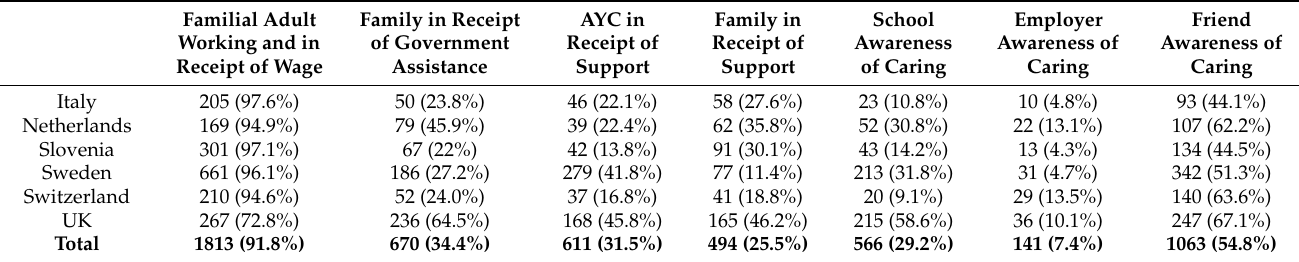
Table 7. Formal and informal support received in connection to caring role, as indicated by AYCs across the six